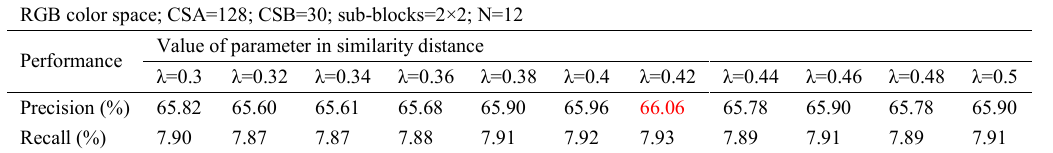
Table 5. Average retrieval precision and recall of different λ ranged from 0.3 to 0.5